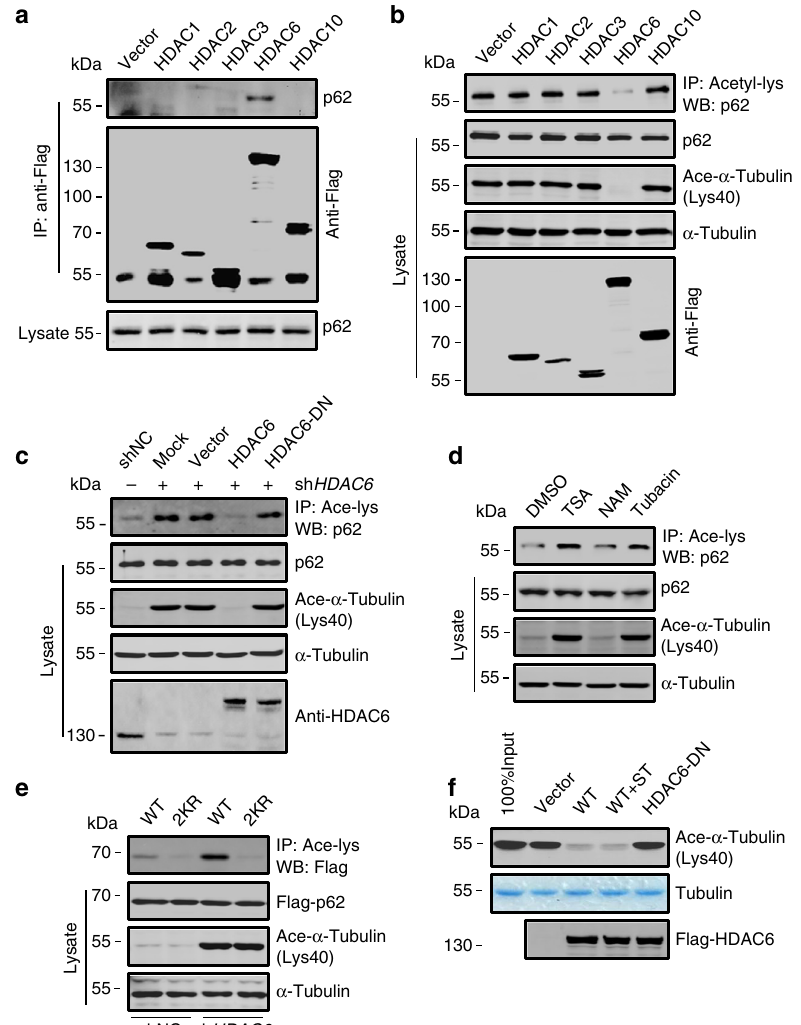
Fig. 4 p62 is deacetylated by HDAC6. a Co-precipitation of endogenous p62 with each of the indicated Flag-tagged deacetylases from HEK293T cells. b p62 acetylation in HeLa cells overexpressing the individual deacetylases. c p62 acetylation in HEK293 cells transfected with Flag-tagged WT HDAC6 or the HDAC6-DN 48 h after HDAC6 shRNA infection. d Acetylation of p62 in HEK293 cells treated with TSA, NAM or Tubacin. e Acetylation of Flag-tagged WT p62 and p62-2KR in HEK293 cells infected with lentivirus expressing HDAC6 shRNA. f Puri fi ed assembled microtubules were incubated with Flag- tagged WT HDAC6 or HDAC6-DN immunoprecipitated from fed or starved HEK293T cells. Acetylation of α -tubulin in the incubation was detected by western blot using an antibody against acetylated α -tubulin (Lys40). Source data are provided as a Source Data fi